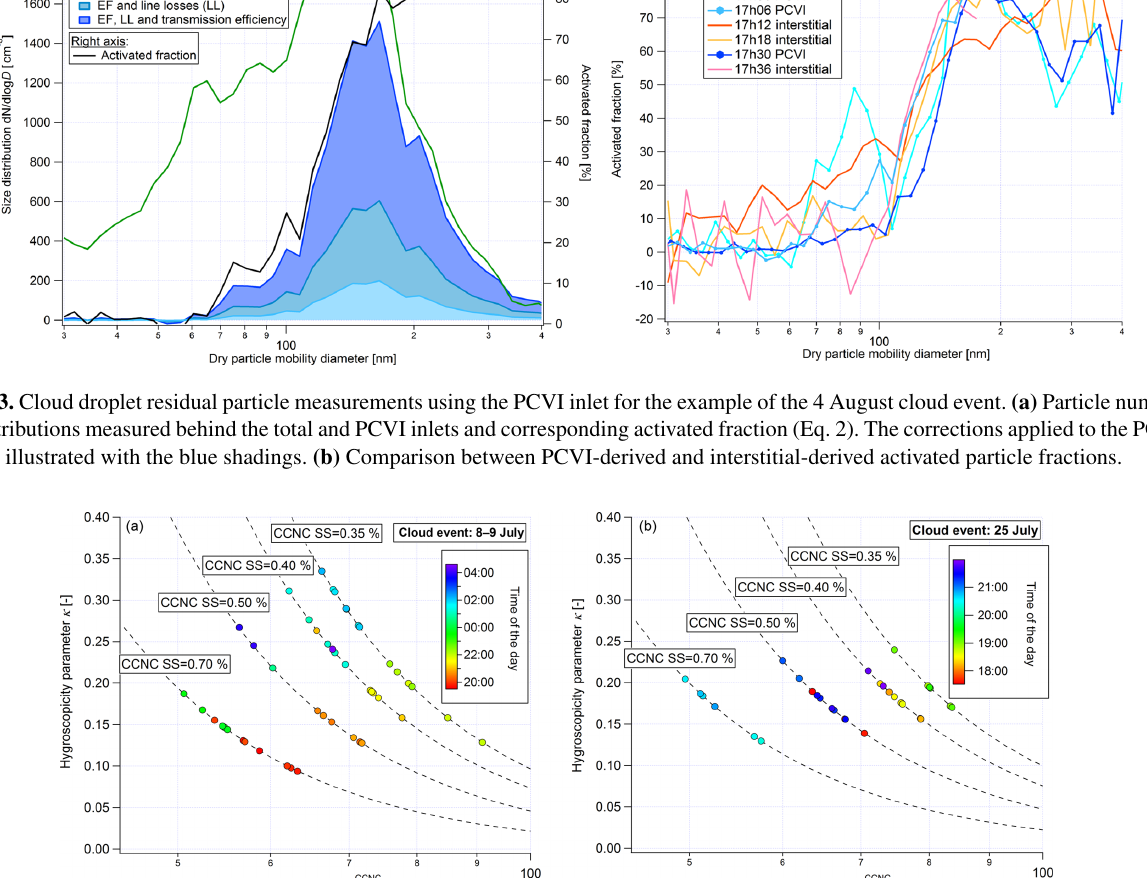
κ (Sect. 3.4) into the κ -Köhler equation (Eq. 3). In the